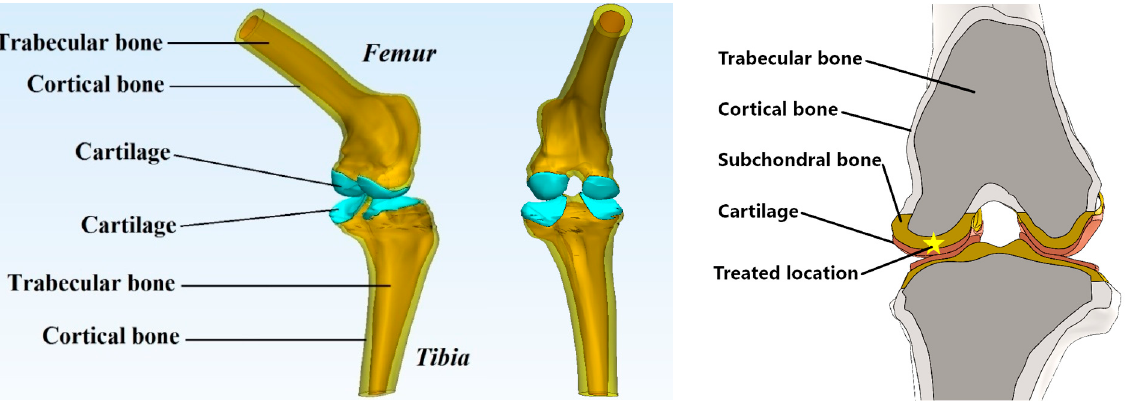
Figure 2. Virtual reconstruction of bone tissues, the designed cartilage, and treated location of Case 0 (Healthy); The yellow asterisk indicates where the collagen implant was inserted.